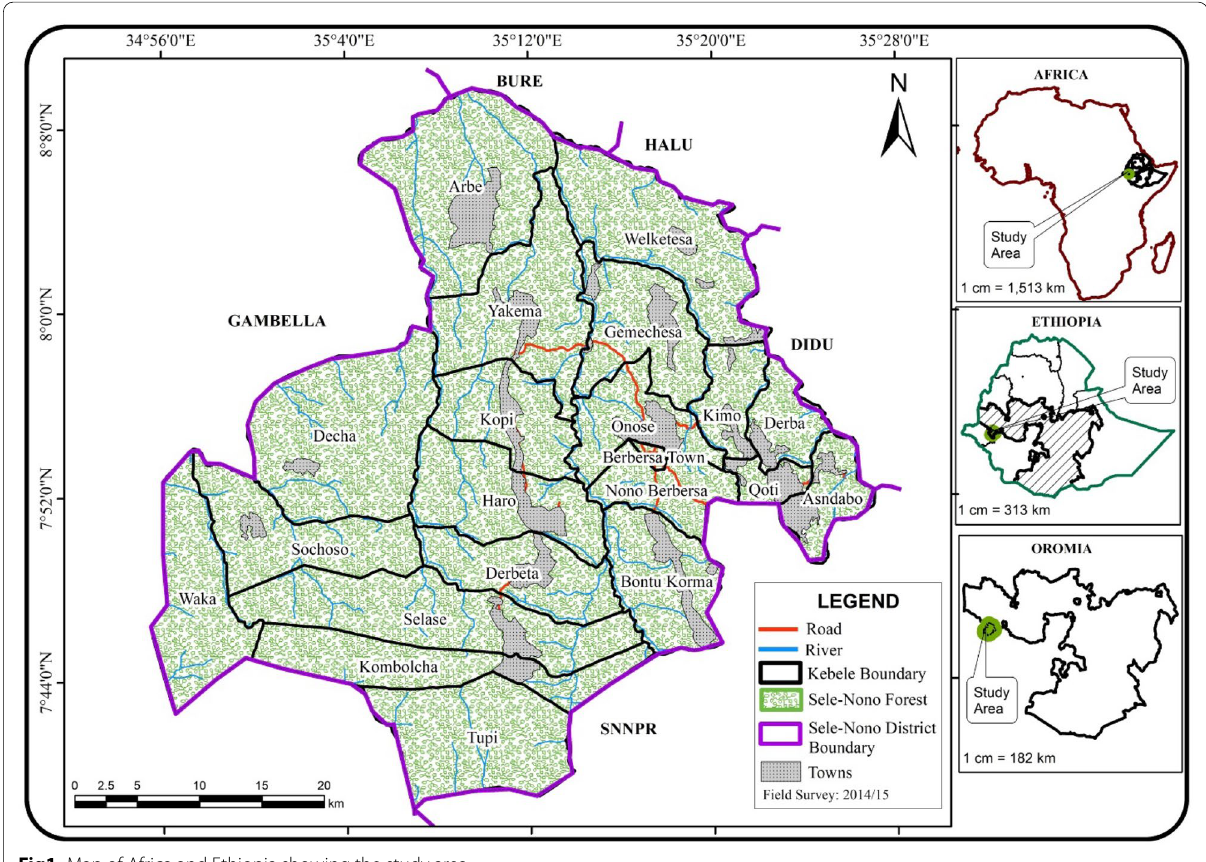
Fig1 Map of Africa and Ethiopia showing the study area